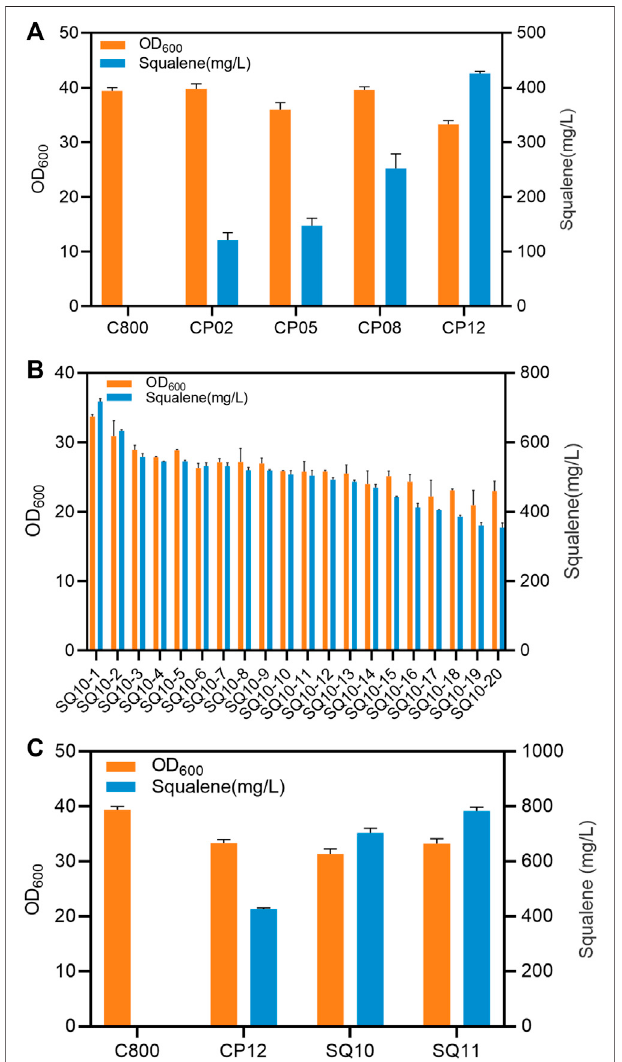
FIGURE 3 | The in fl uence of copy numbers of tHMG1/IDI1. (A) Growth and squalene accumulation of strains with different copy numbers of tHMG1 and IDI1 in shake- fl asks at 96 h. (B) Growth and squalene accumulation of strains of integrating tHMG1 and IDI1 in multiple copy site Ty2 in 24-well plates at 96 h. (C) Growth and squalene accumulation of different strains in shake fl asks at 96 h. Error bars show SD values.